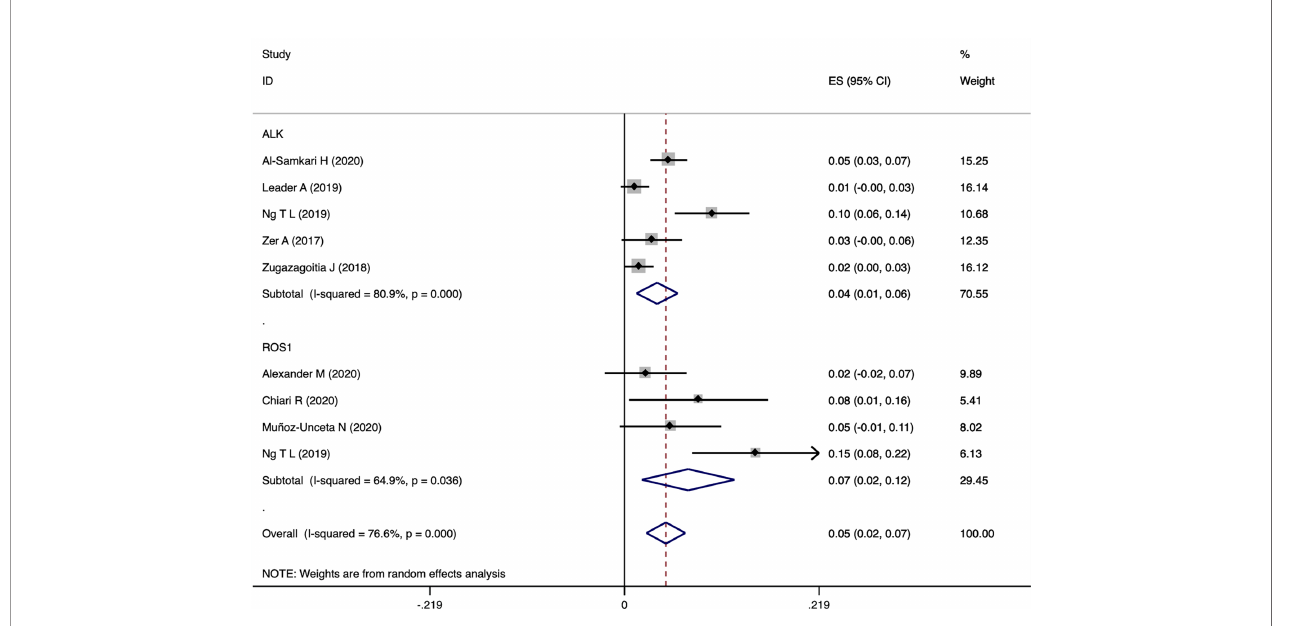
FIGURE 7 | Pooled rate estimates for ATE in patients with ALK or ROS1